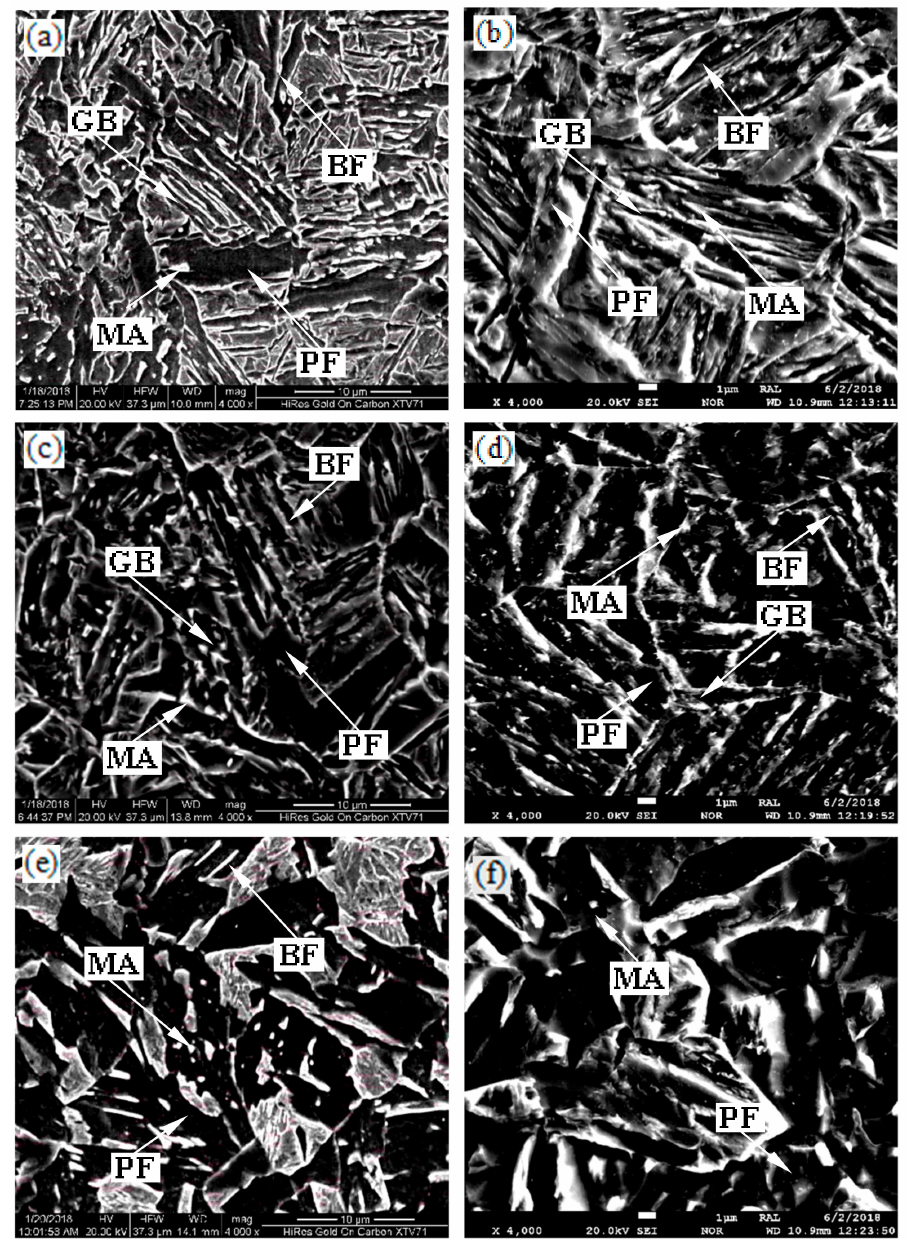
Figure 7. SEM micrographs of the specimens held at ( a ) 550 ◦ C; ( b ) 600 ◦ C; ( c ) 650 ◦ C; ( d ) 700 ◦ C; ( e ) 750 ◦ C; ( f ) 800 ◦